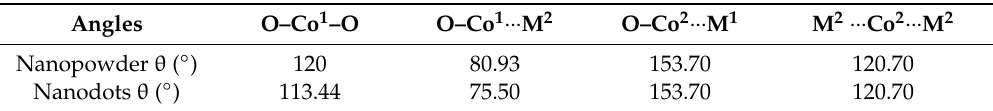
Table 4. Three-body simulation results at Co K-edge of the CFO standard and the nanodots annealed at 600 ◦ C and then 950 ◦ C.